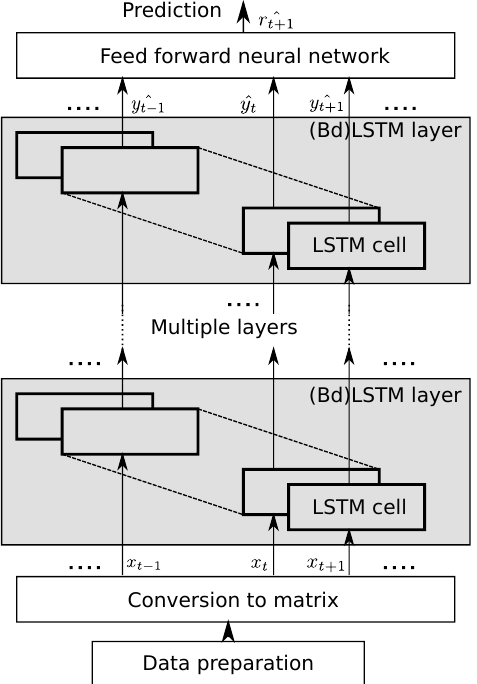
Figure 6. Architecture of the LSTM ANN used for network throughput